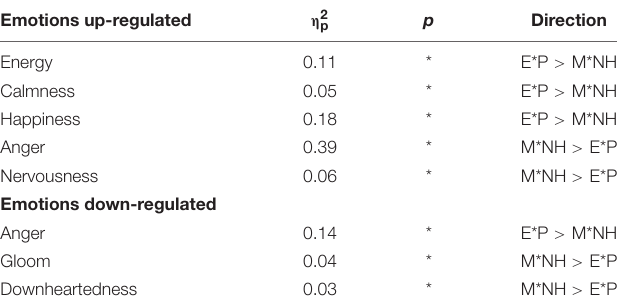
TABLE 8 | Overview of specific emotion regulations (up-regulation or down-regulation) reported by M*NH and E*P subgroups. Emotions up-regulated η 2 p p Direction